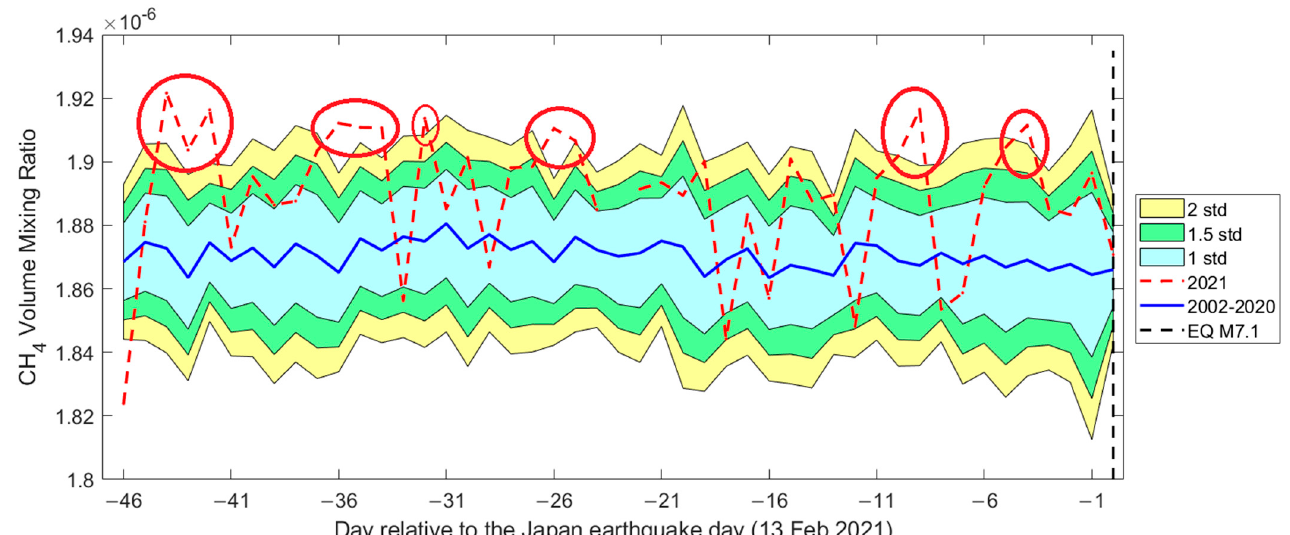
Figure 16. Atmospheric analysis of methane (CH 4 ) concentration in the 45 days before the Mw = 7.1 Japan 13 February 2021, earthquake in a round area of 4° radius centred on the epicentre. Gaps in the 2021 time series (red dashed line) are due to unavailable values for some poor (or even absent) satellite coverage in the area. We highlight the anomalies with red circles, where a bold red circle means a significant and more robust anomaly.